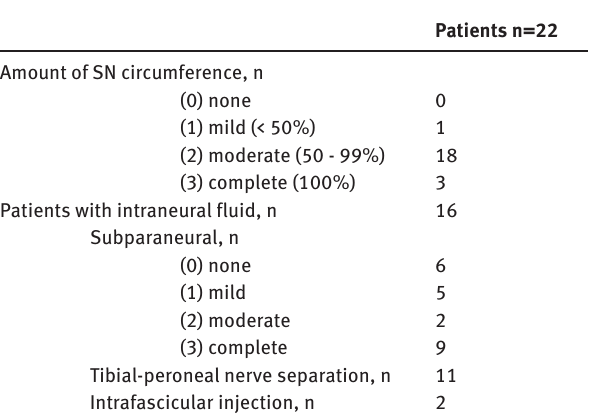
Table 5: Extent of fluid accumulation around the circumference of the SN shown by MRI on the evening after surgery.